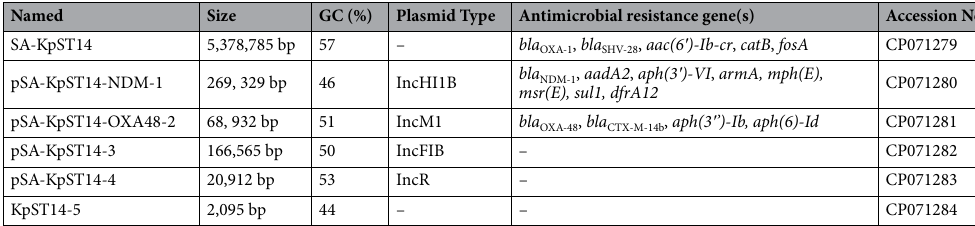
Table 2. Genetic elements sizes and replicon types of plasmids of SA-KpST14 isolate and the presence of antimicrobial resistance genes.